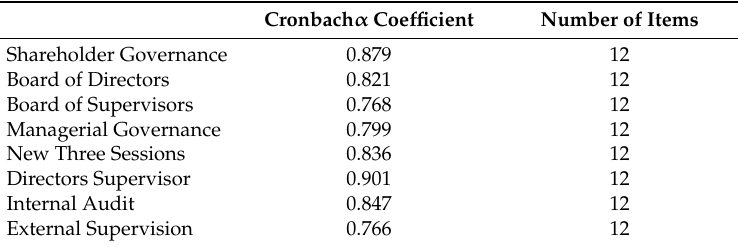
Table 1. Cronbach α coefficients.